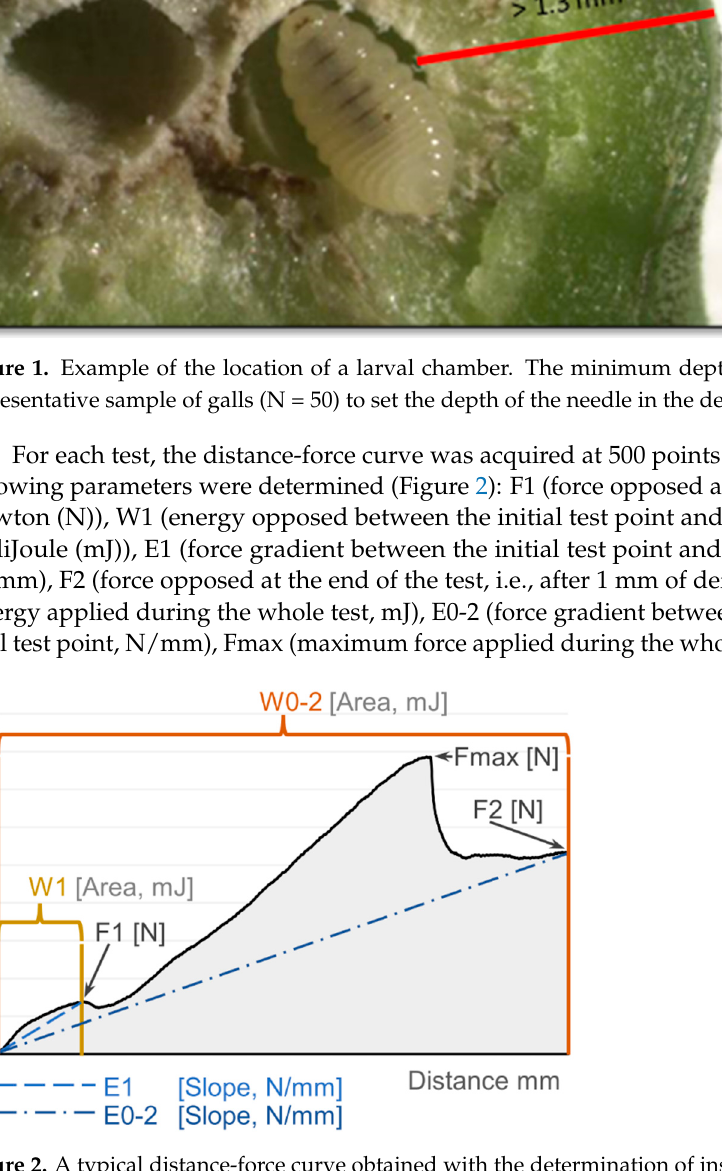
Figure 2. A typical distance-force curve obtained with the determination of instrumental mechanical properties (1-mm needle penetration). The calculated parameters are annotated on the